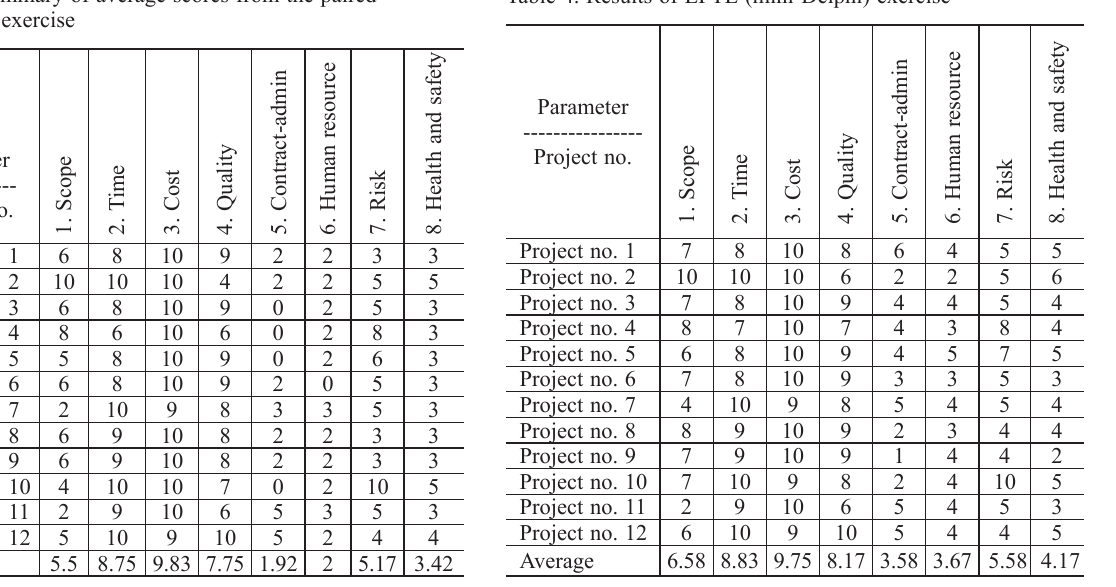
Table 4. Results of EFTE (mini-Delphi) exercise